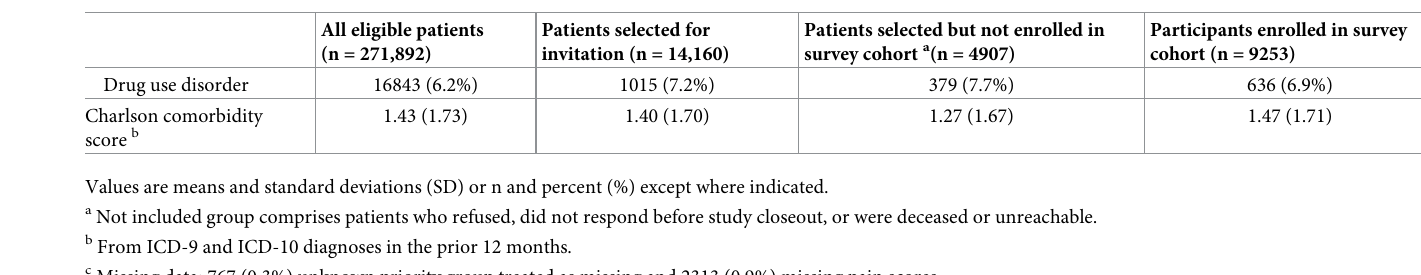
Table 2 shows opioid treatment received by participation status. Most patients were treated with only short-acting opioids. The most common opioids received were hydrocodone